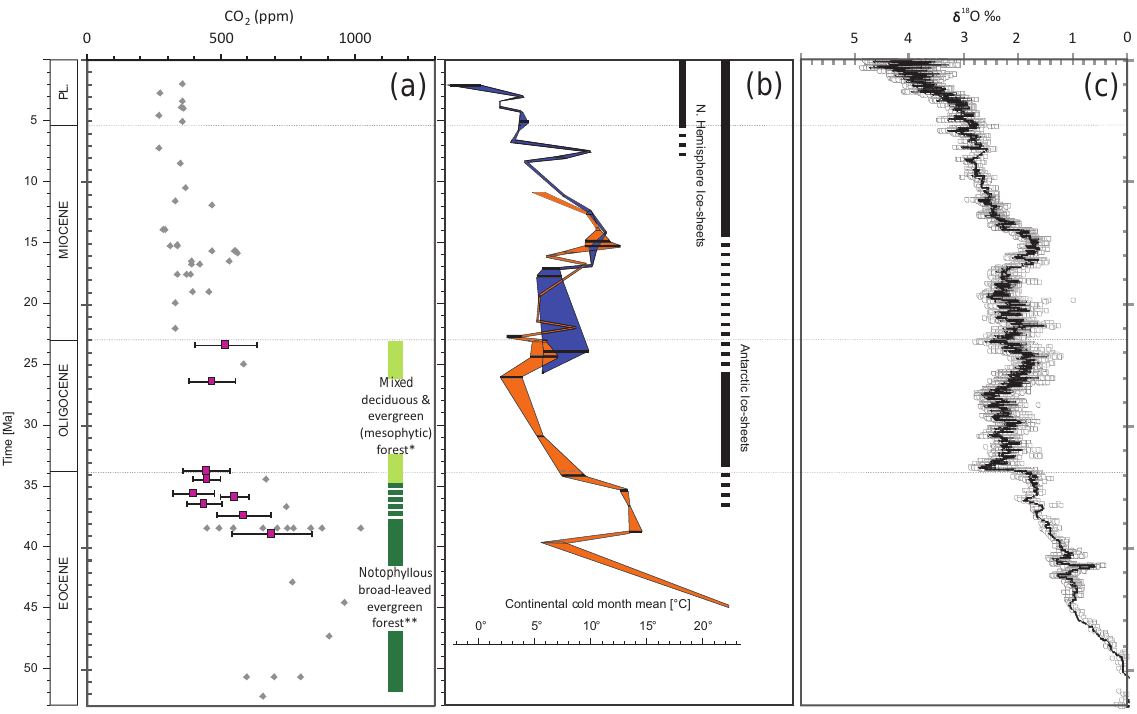
Figure 4. CO 2 , vegetation and climate trends through the Cenozoic. The most significant changes in p CO 2 , forest ecosystem composition (a) and continental climate as tracked by terrestrial plants (b) take place in the late Eocene, whereas the most significant change in global temperatures as tracked by marine isotopes (c) takes place at the Eocene–Oligocene boundary, indicating that the significant climate transition at the Eocene–Oligocene boundary was preceded by a gradual decrease in p CO 2 during the late Eocene. (a) p CO 2 estimates from fossil stomata (this study pink with black error bars) in the context of existing stomatal proxy estimates (in grey from Beerling and Royer, 2011) in a chronostratigraphic framework. Vertical bar shows the gradual late Eocene vegetational restructuring of the dominantly evergreen forests of the Weißelster and North Bohemian basins studied here (dark green to light green), suggesting a potential causal role of p CO 2 decline in the changing ecological forest composition ( ∗ Kunzmann and Walther, 2012; ∗∗ Kvaˇcek et al., 2014; Kunzmann et al., 2015). Note that the assigned ages for CO 2 values from this study are estimated based on the biostratigraphic controls presented in Fig. 3. Absolute ages were not available for any of the nine fossil study sites (Table 2) although clear superposition information is available throughout allowing good estimates of the temporal sequence of CO 2 estimates (see Fig. 3). (b) Continental temperature curve: record of continental cold month mean temperature for central Europe during the last 45My, redrawn from Mosbrugger et al. (2005). Horizontal bars represent coexistence intervals. Orange curve shows data from the Weißelster and Lausitz Basins, northeast Germany; blue curve shows data from the Lower Rhine Basin, northwest Germany (see Mosbrugger et al. (2005) for details). (c) Global climate (temperature) curve derived from stacked records of deep-sea benthic foraminiferal oxygen-isotopes: a proxy for relative changes in marine temperature in the late Eocene prior to ice build up, based on updated records from Deep Sea Drilling Project and Ocean Drilling Program sites. Raw data is smoothed by using 15-point running mean, to minimize biases introduced by uneven temporal and spatial distribution of records – data from Zachos et al. (2001, 2008) and references